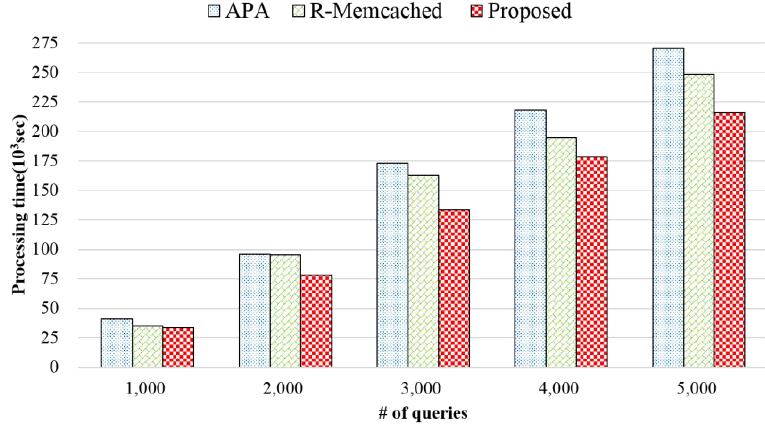
Figure 21. Query processing time according to the number of query requests.